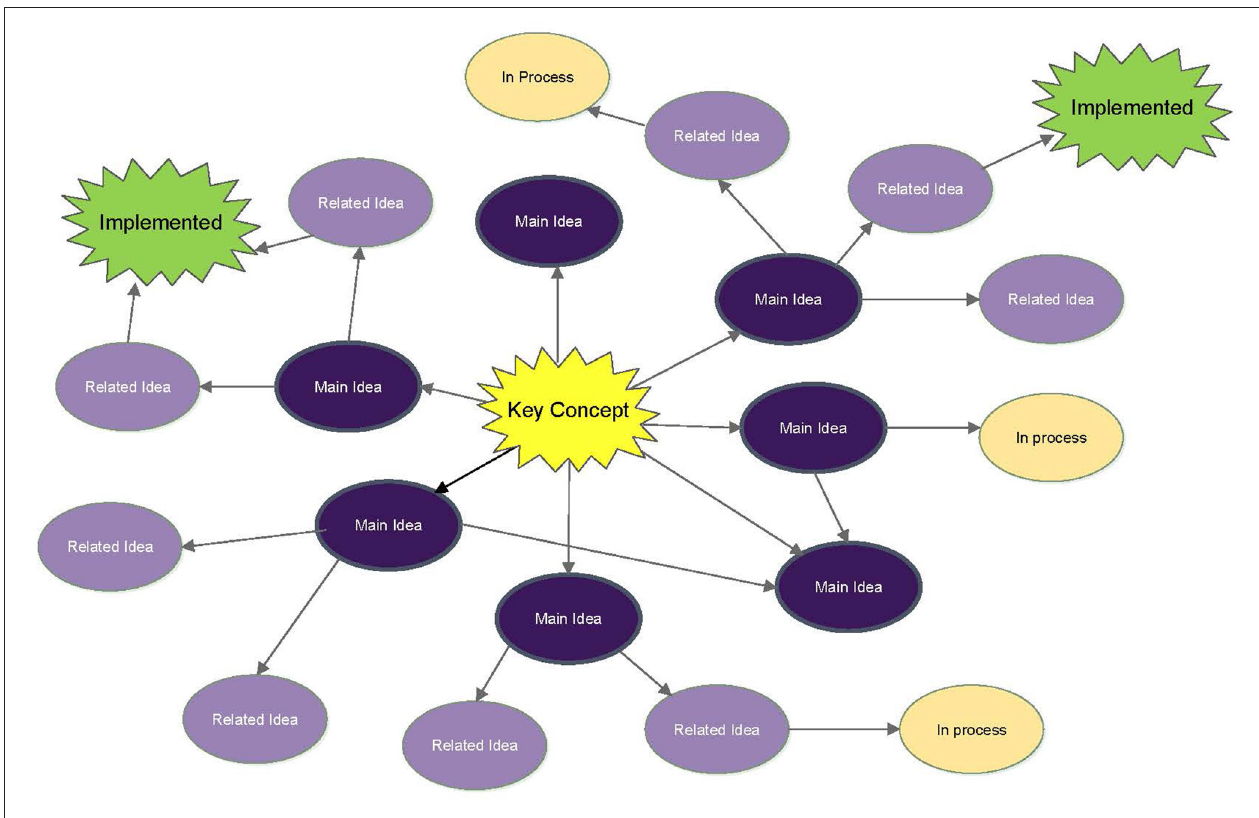
FIGURE 1 | Example concept